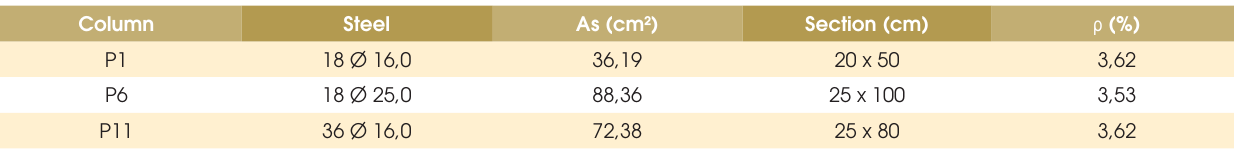
Table 2 – Dimensions and steel of columns studied for the 20-floor model